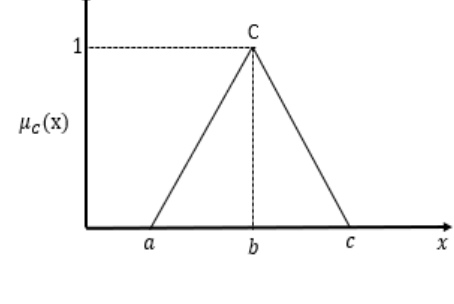
Figure 5. Triangular fuzzy